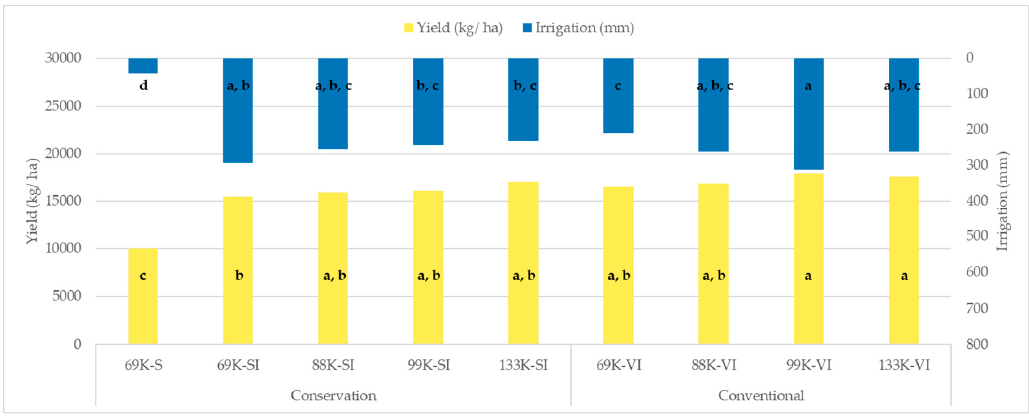
Figure 13. Three years’ average yield (kg/ha) produced in SIRP field by each treatment and statistical analysis results.